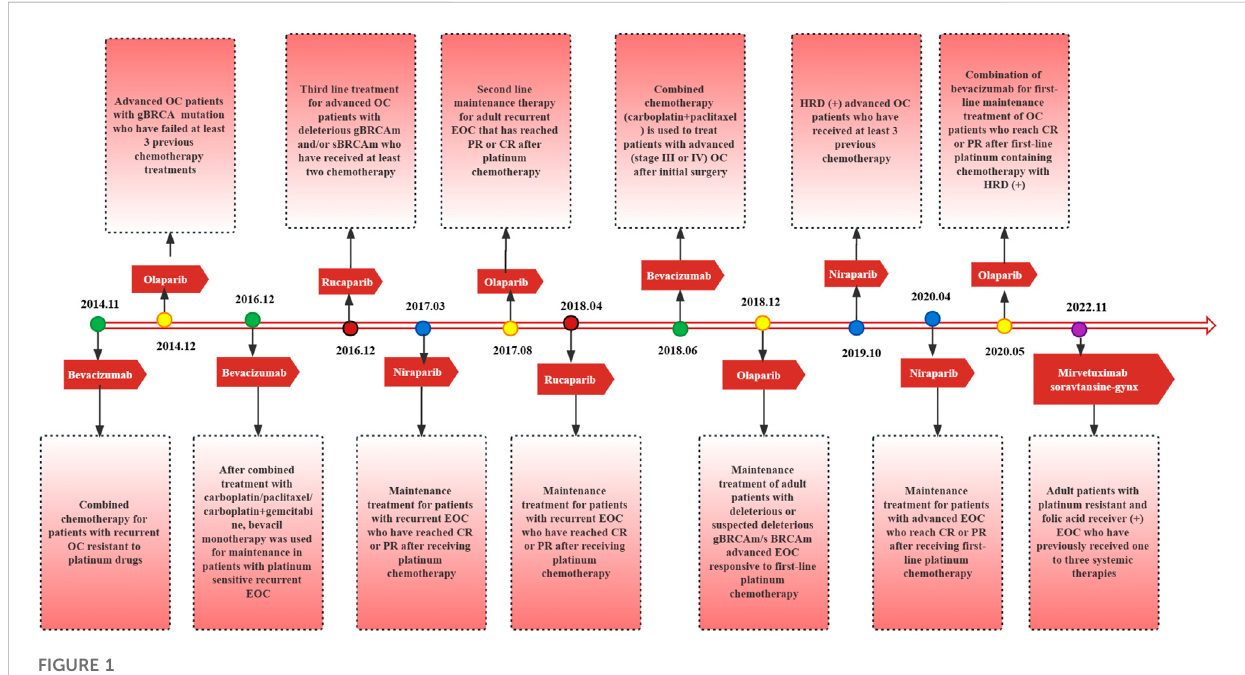
FIGURE 1 Targeted drugs approved by FDA, approval time and corresponding